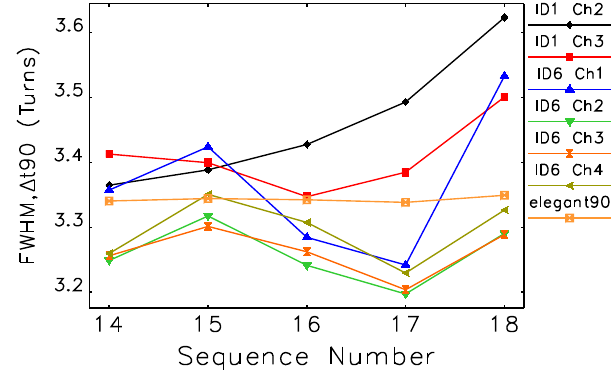
FIG. 32. Five-strike FWHM loss durations taken from ID1 and ID6 fast BLMs compared with PELEGANT 90% loss increment. The BLMs in ID1 are labeled ID1_ChM where M ¼ 2 ; 3 ; and the BLMs in ID6 are labeled ID6_ChN where N ¼ 1 ; 2 ; 3 ; 4